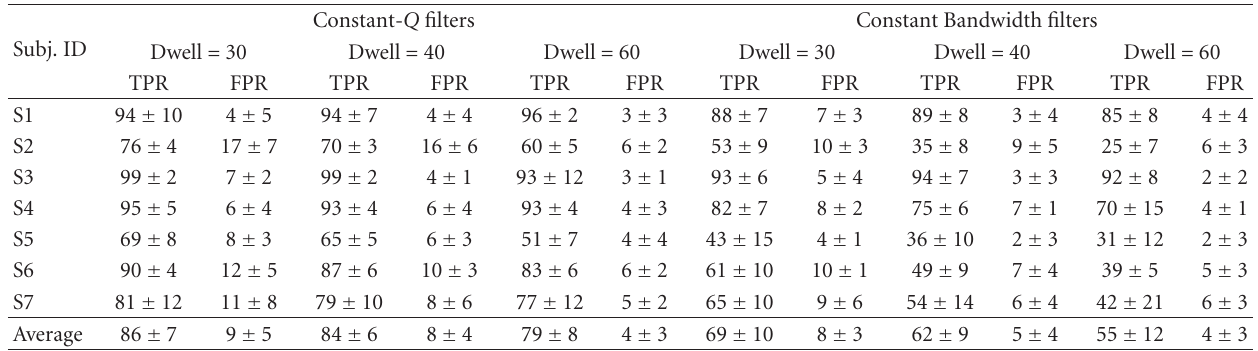
Table 1: Individual performance using constant- Q filters and constant bandwidth filters for di ff erent dwell times (threshold = 0.5). Subj. ID